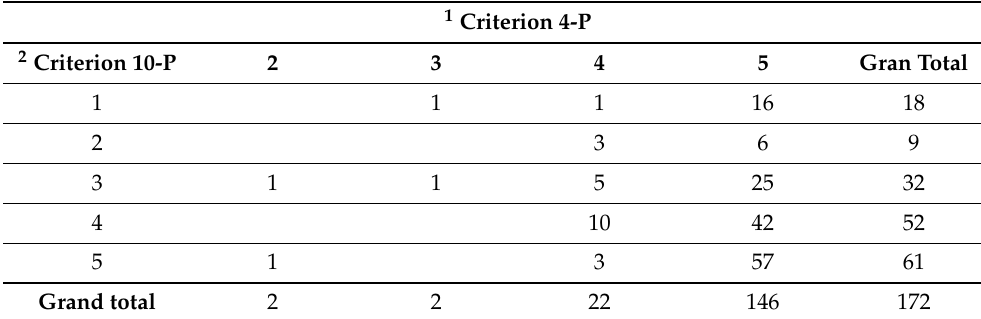
Table 6. Cross-check between the 4-P and 10-P criteria.